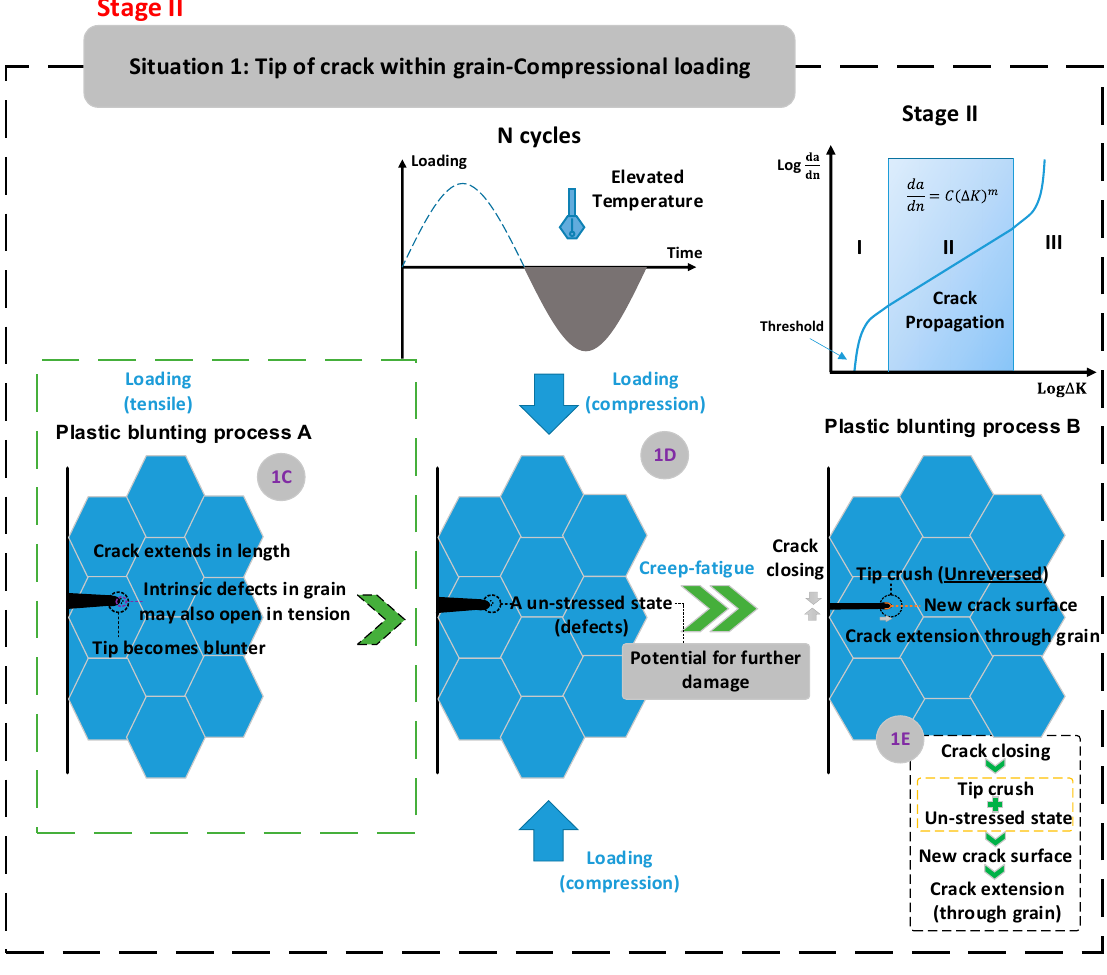
Figure 10. Crack tip within a grain—Compressional loading.